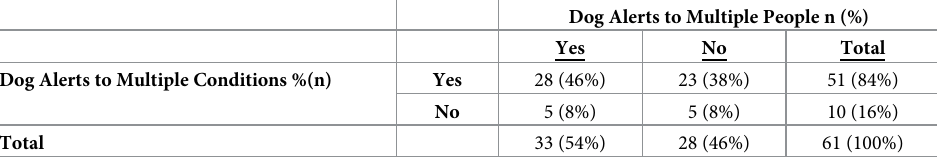
Table 3. The percentage of participants that report that their dog alerts to multiple conditions, multiple people, and